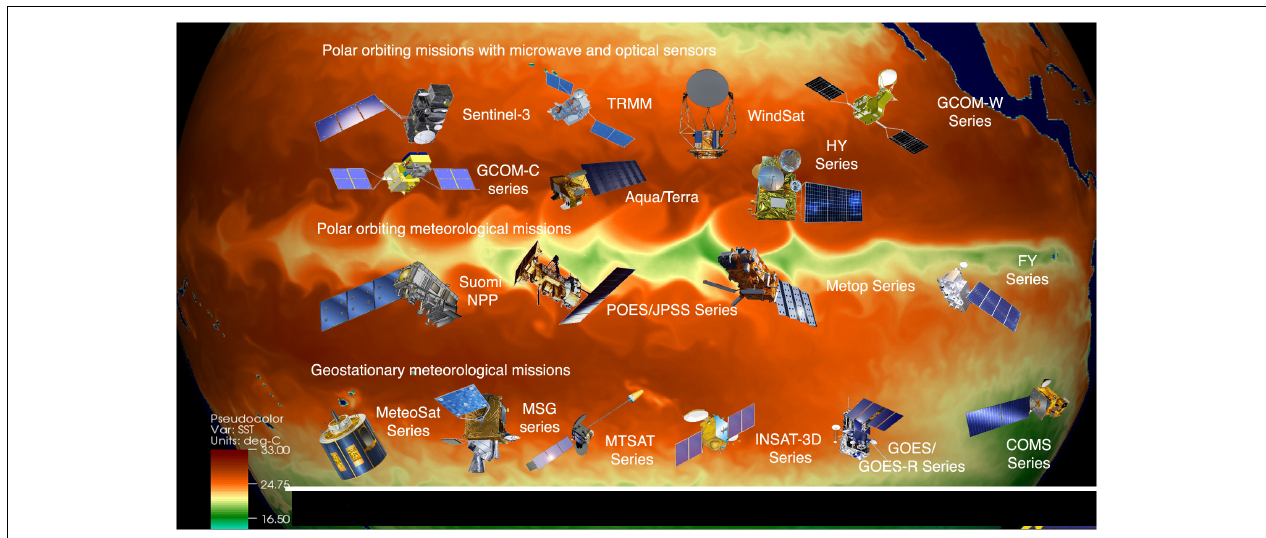
FIGURE 1 | The main satellite missions contributing to the current SST constellation. (Reproduced by permission under CC BY 4.0 from http://doi.org/10.6084/m9. figshare.7291694.